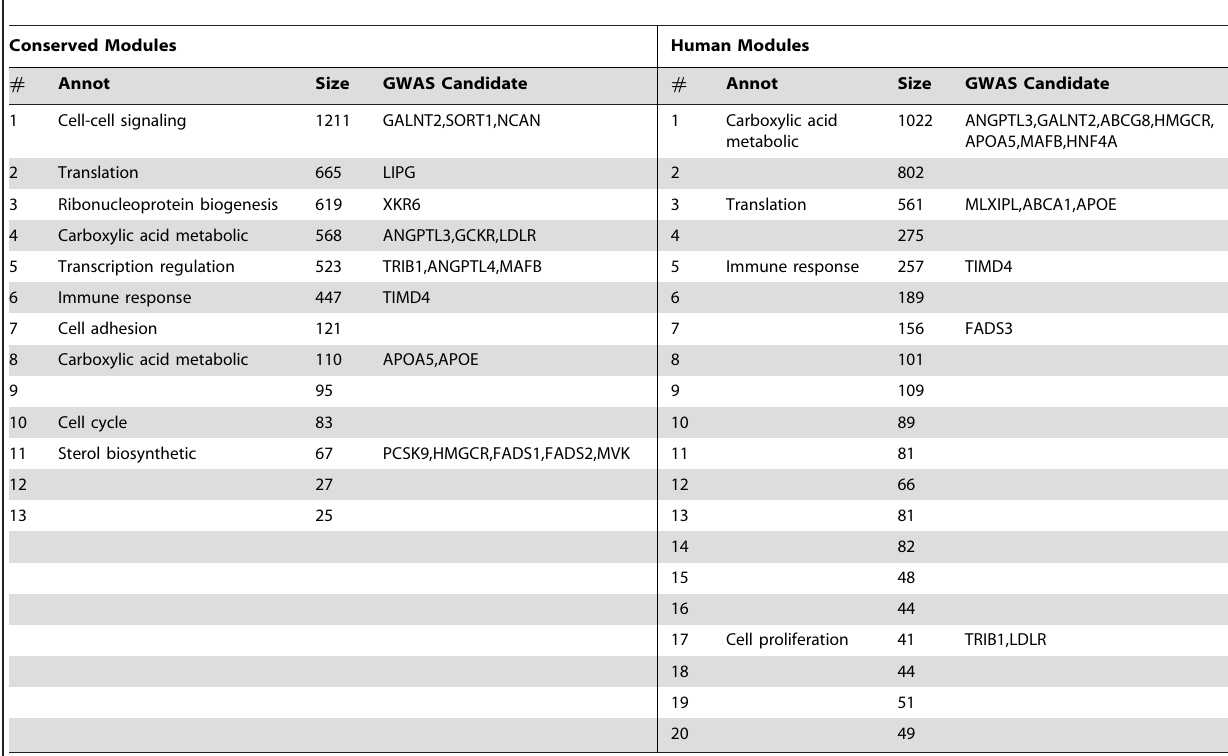
Table 2. Annotation of GWAS lipid candidate genes using conserved co-expression modules as well as modules based on human data